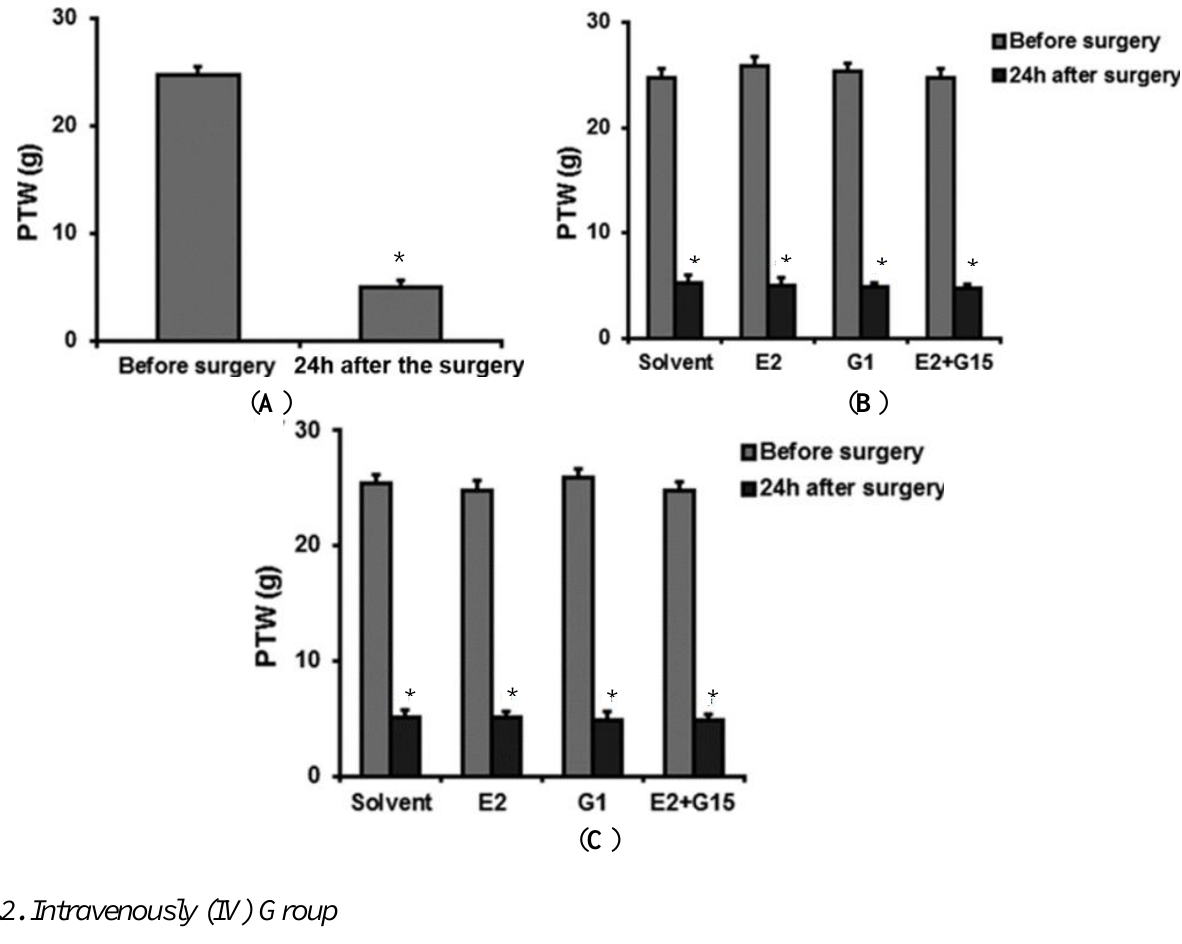
Figure 1. ( A ) The PWT of rats before and 24 h after the incisional surgery. The PWT of the rats dropped significantly 24 h after the incisional surgery * p < 0.05; ( B ) The PWT of rats before and after the incisional surgery of the intravenously (IV) group before administration of the indicated drug/drugs [17-β-estradiol (E2), GPER-selective agonist (G1), E2 + GPER-selective antagonist (G15)]. The PWT is presented as mean ± standard error of the mean (SEM). There was no statistically significant difference between the groups; and ( C ) The PWT of rats before and after the incisional surgery of the intrathecal (IT) group before administration of the indicated drug/drugs (E2, G1, E2 + G15). The PWT was presented as mean ± SEM in the figure. There was no statistically significant difference between the